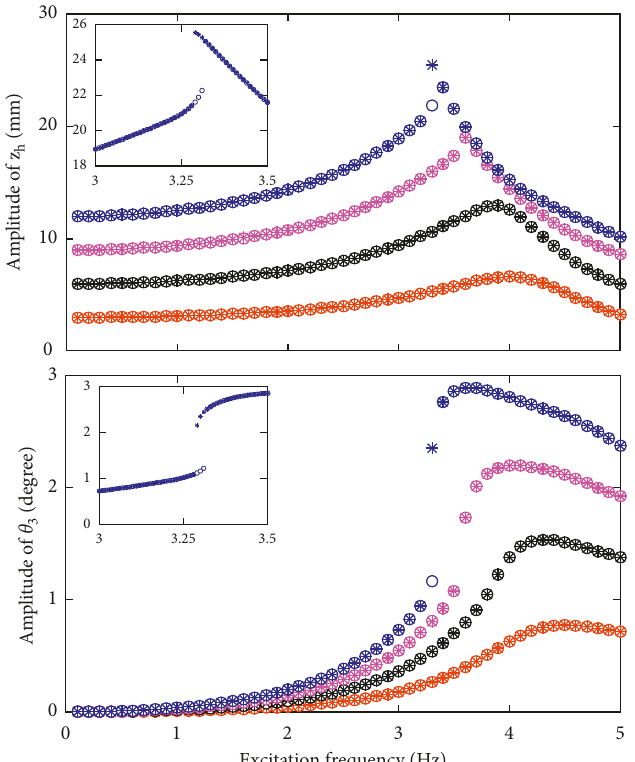
Figure 9: Amplitude of the vertical displacement of the hip joint and the angular displacement of the head with four different excitation amplitudes using the nonlinear human model (the circle and asterisk symbols indicate the amplitude values with increasing and decreasing excitation frequency, respectively).